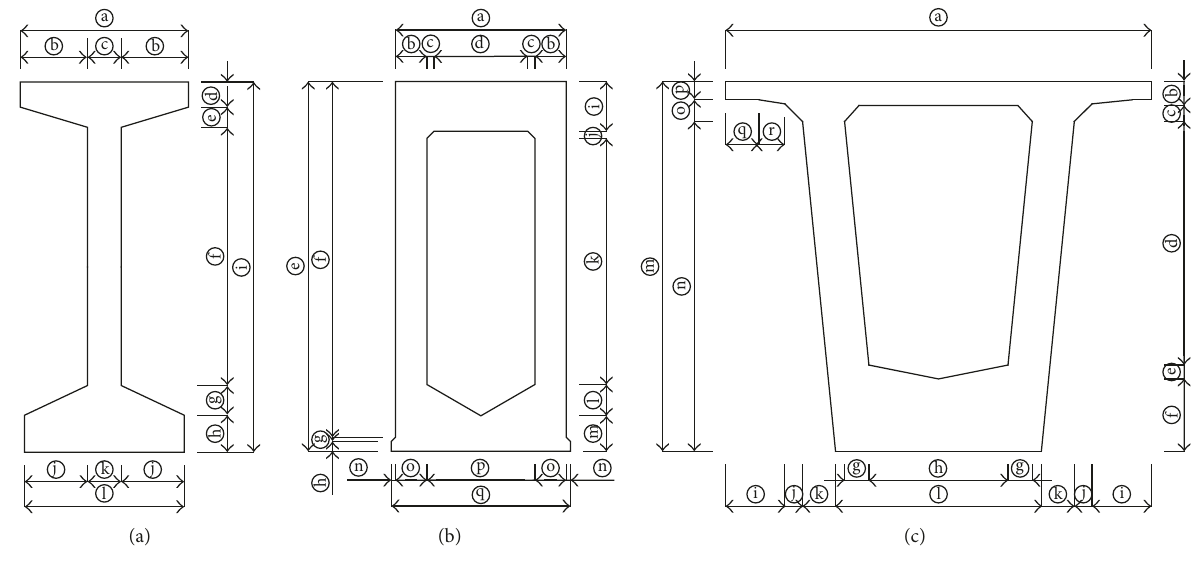
Figure 2: Typical cross sections of PSC bridges. (a) I girder; (b) box girder; (c) WPC girder. Table 3: Cross section dimension of I, box, and WPC girders by span